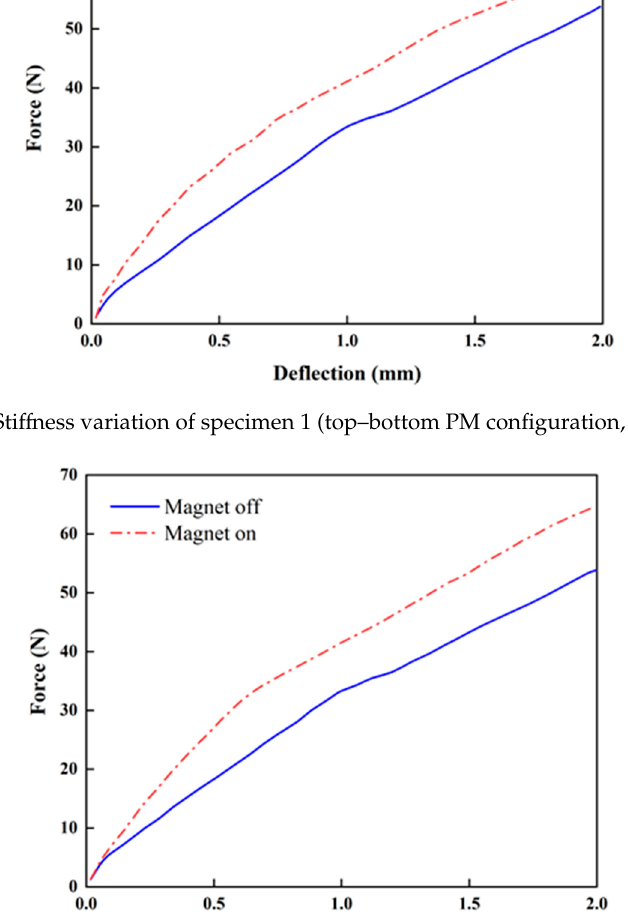
Figure 8. Stiffness variation of specimen 1 (lateral PM configuration, Figure 6c).